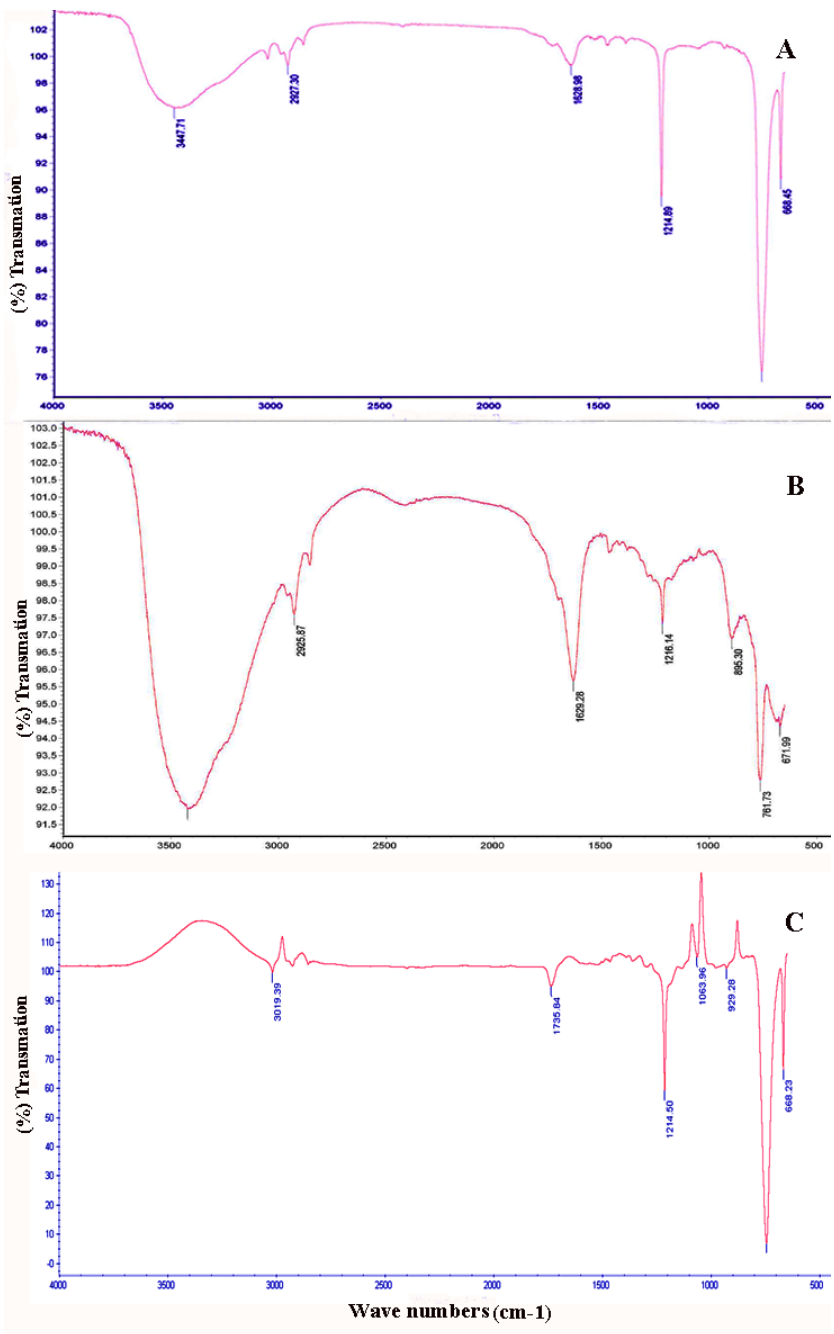
Figure 5. Recorded FT-IR patterns for extracted PHB/PHA ( A ) unclassified Halolamina sp. strain NRS_35, ( B ) Halolamina sediminis sp. strain NRS_38, and ( C ) standard PHB.